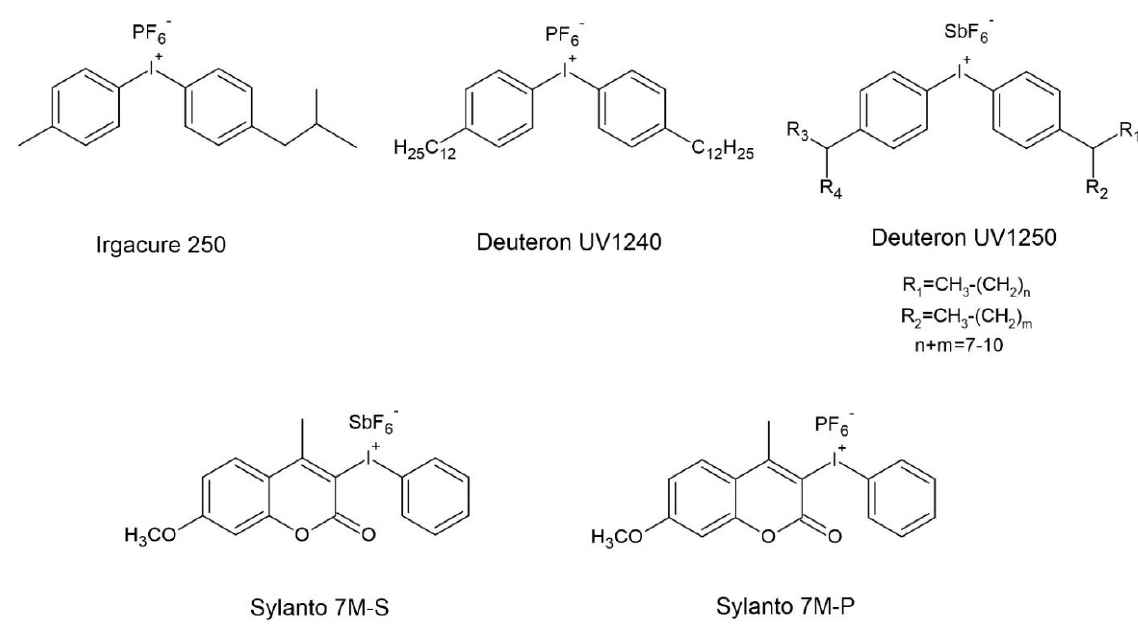
Figure 1. Structure of the cationic photoinitiators based on diaryliodonium cation.